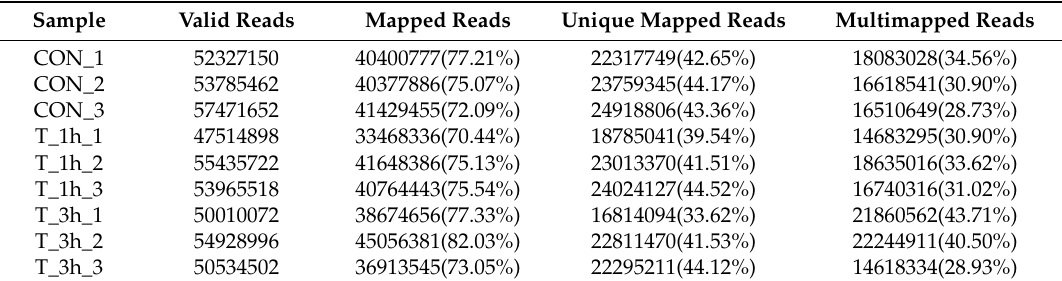
Table 2. Summary of RNA-seq